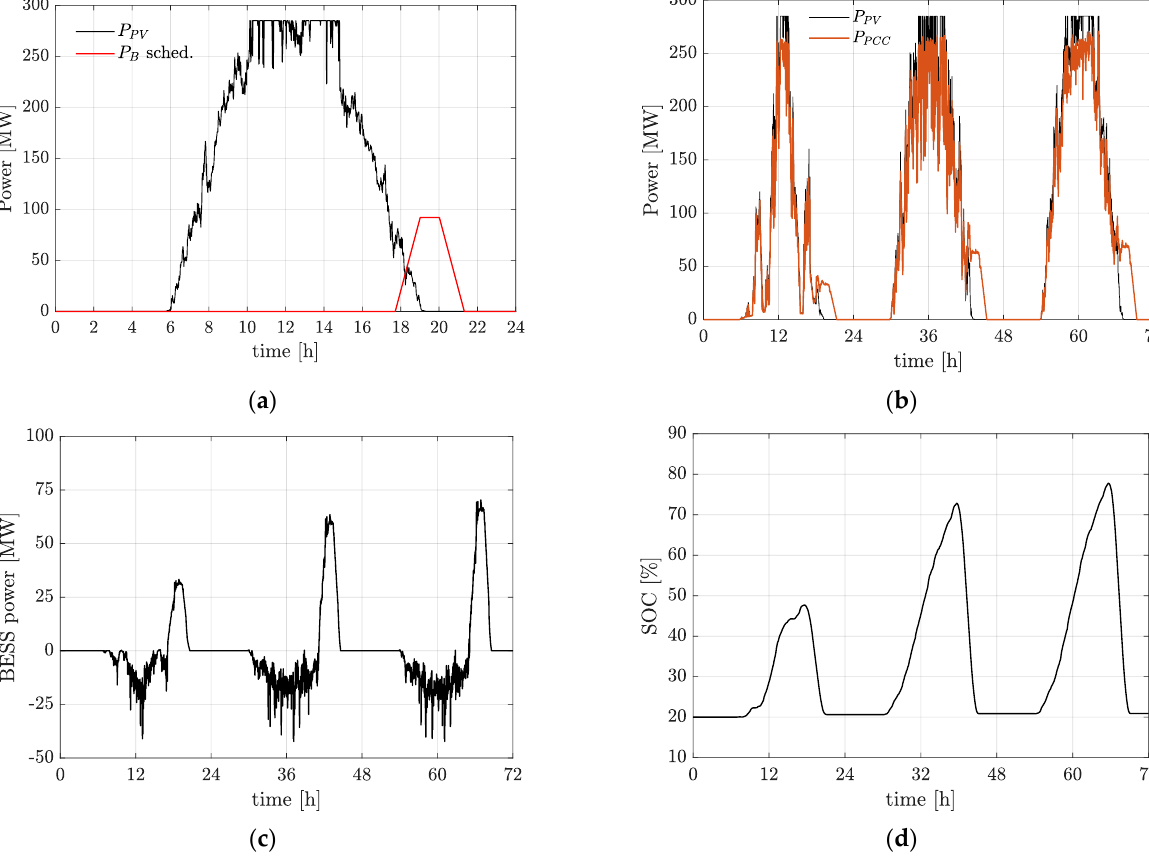
Figure 6. Reference power flows: ( a ) PV power profile (black) and battery scheduled power for energy shifting operation (red) with k = 1; ( b ) PV power and PCC power demand (red) obtained by PFR and ES operating; ( c ) Battery power flow, daytime charging (negative power) and evening discharging (positive power); ( d ) battery SOC profile.